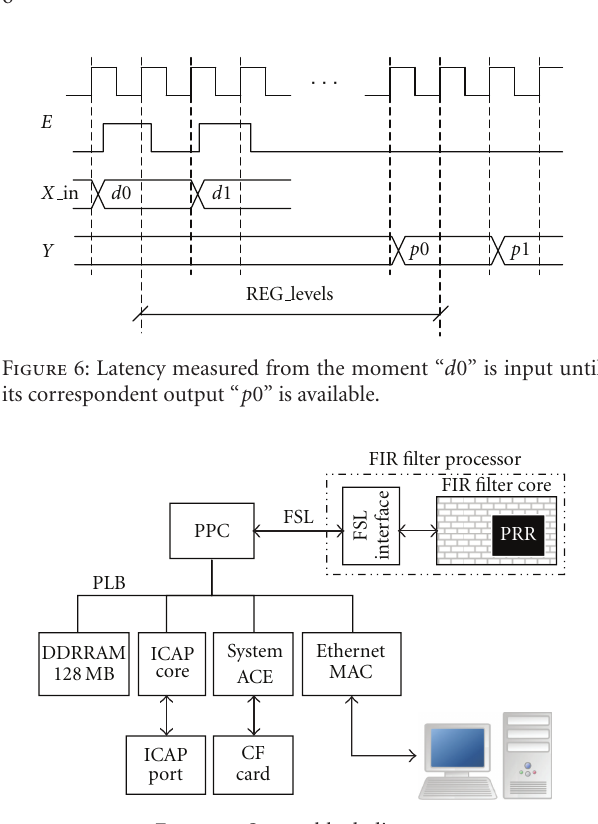
Figure 7: System block